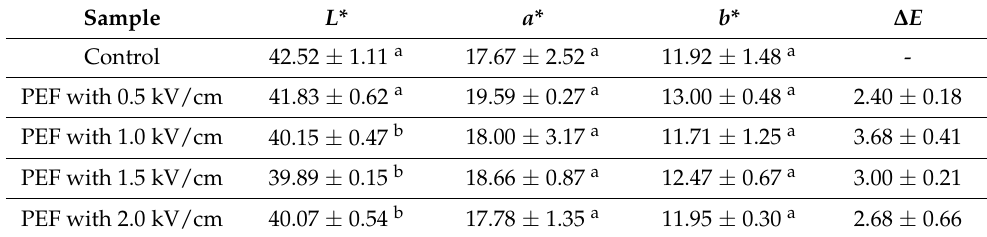
Table 2. Color measurement of beef processed with PEF at different field strengths.